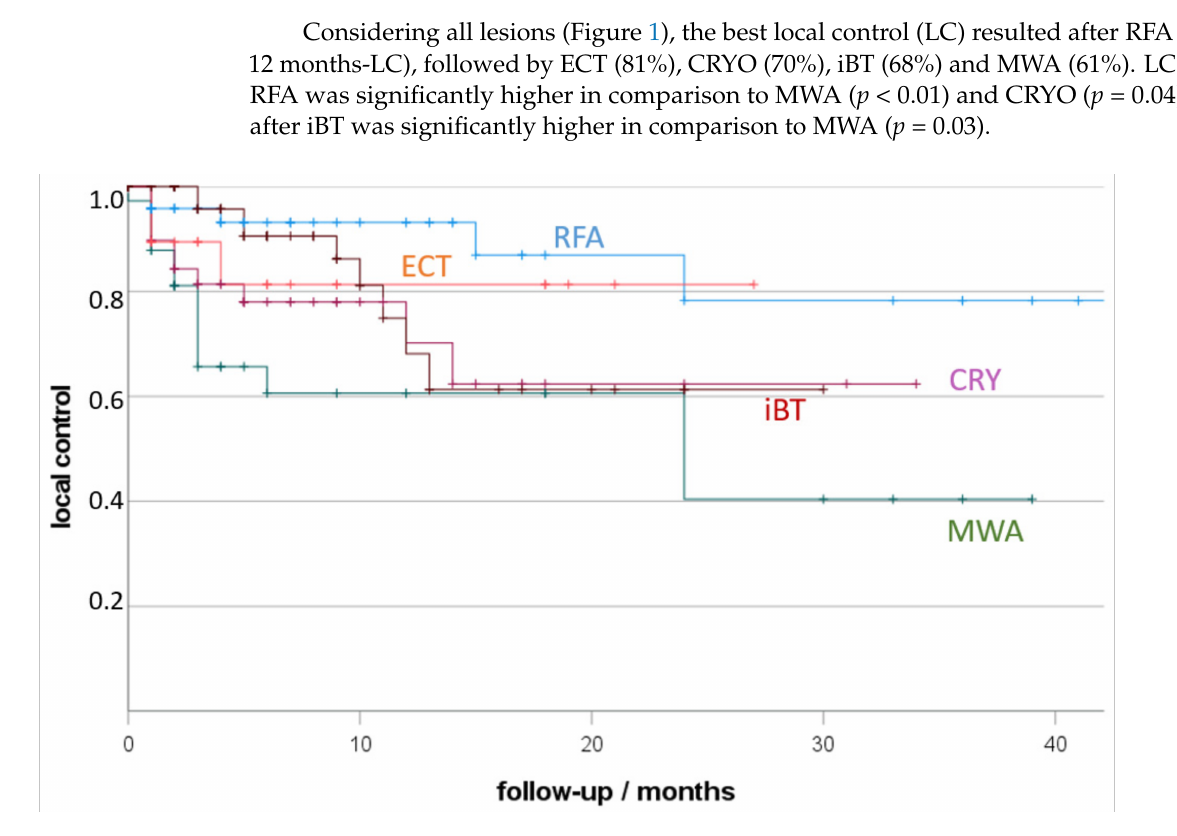
Figure 1. Local tumour control (LTC) depending on treatment (RFA, radiofrequency ablation; MWA, microwave ablation; CRY, cryoablation; ECT, electro-chemotherapy; iBT, interstitial brachytherapy; +, censored). Non-parametric Kaplan-Meier estimate of post-therapy LTC sorted by ablation